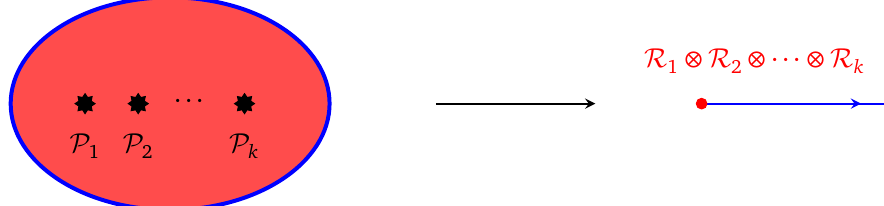
Figure 3: A 6 d surface defect compactified on a K2-chain (shown in red) whose boundary is a K1-cycle (shown in blue) leads to a 4 d local operator (shown in red) living at the end of a line defect corresponding to the K1-cycle (shown in blue). If the K2-chain passes over a puncture P , then the local operator is charged under a i representation R of P . See i i